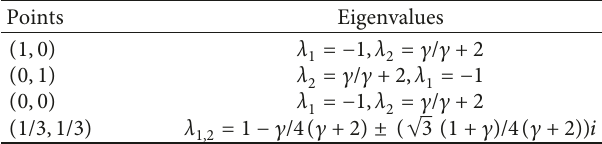
Table 1: The eigenvalues of equilibria. Points Eigenvalues ( 1 , 0